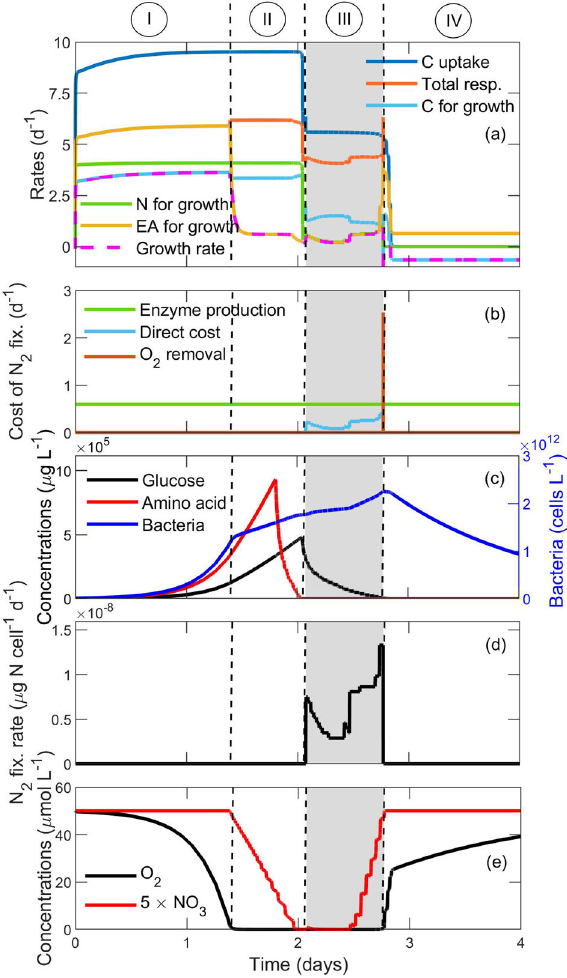
Fig. 3 Cellular rates and resource concentrations at a radial distance of 0.027cm from the center of a particle of radius 0.125cm. a Size-speci fi c rates of C uptake (dark blue), total respiration (orange), available C for growth (light blue), available N for growth (green), available EA (electron acceptor O 2 , NO 3 (cid:1) , and SO 42 (cid:1) ; yellow), and growth rate of a cell (dashed magenta). Regions I, II, III, and IV represent situations when a cell is limited by C, EA, co-limited by N and EA, N, and showing negative growth rate (see fi xation in terms of direct text). b Respiratory costs related to N 2 respiration, enzyme production, and O 2 removal. c Glucose, amino acid, and fi xation rate. e O bacterial concentrations in the particle. d Cellular N and 2 2 NO 3 (cid:1) concentrations in the particle. The gray area represents the time fi interval of N 2